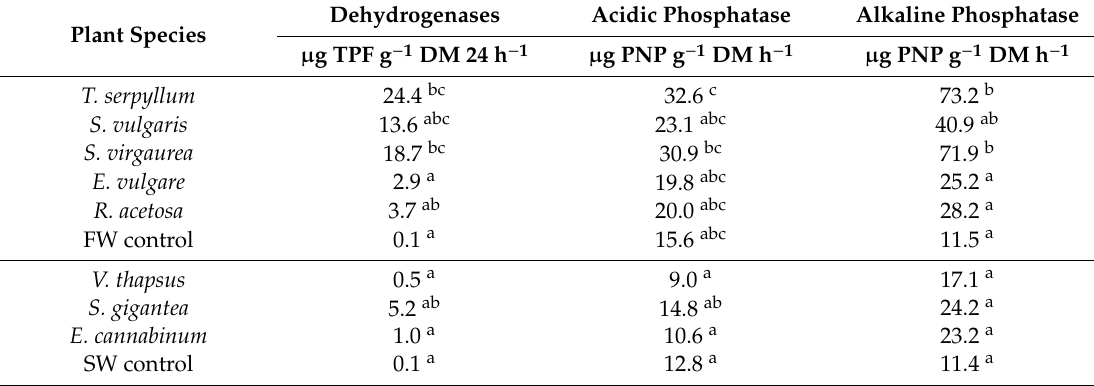
Table 4. Enzyme activities in FW and SW